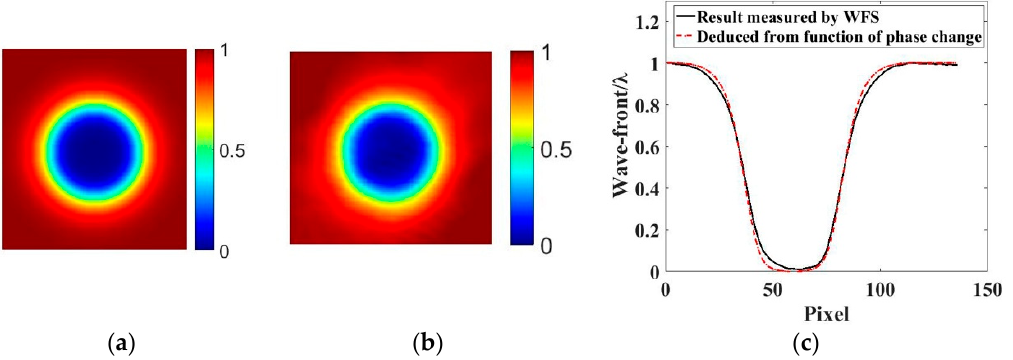
Figure 7. Comparison of the designed wave-front and the actual one. ( a ) Wave-front designed using Equation (4). ( b )Actual wave-front measured by the WFS. ( c ) Comparison of the central row one-dimensional (1D)